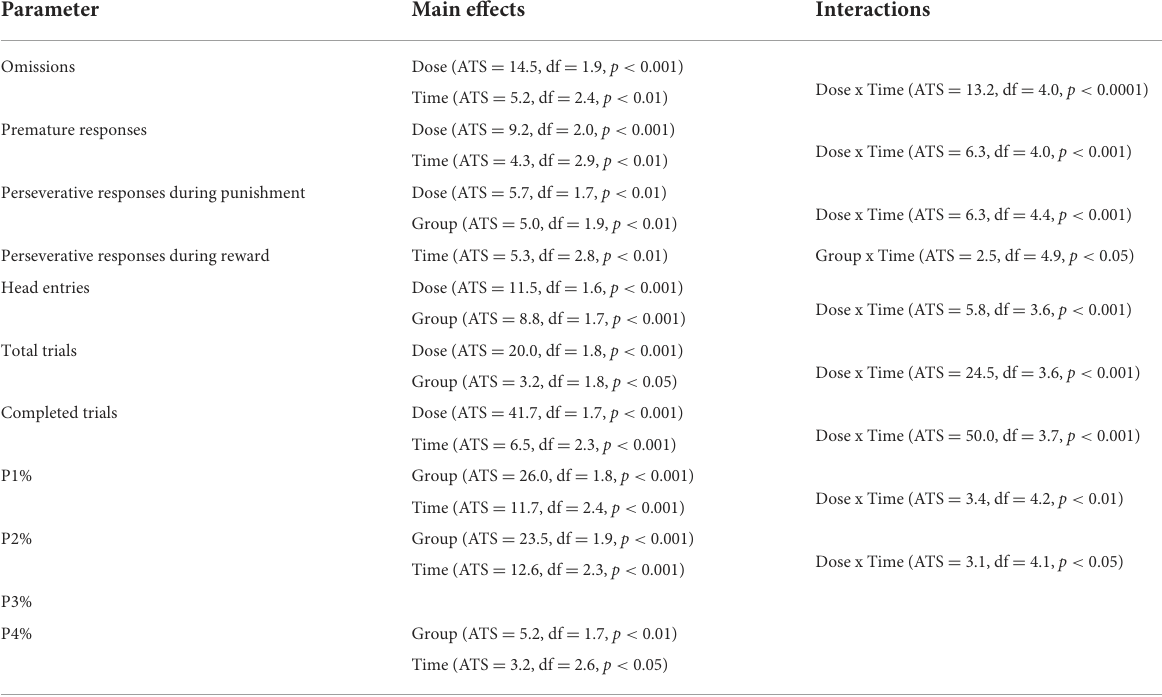
TABLE 1 Statistical main effects and interactions on rGT parameters after naltrexone